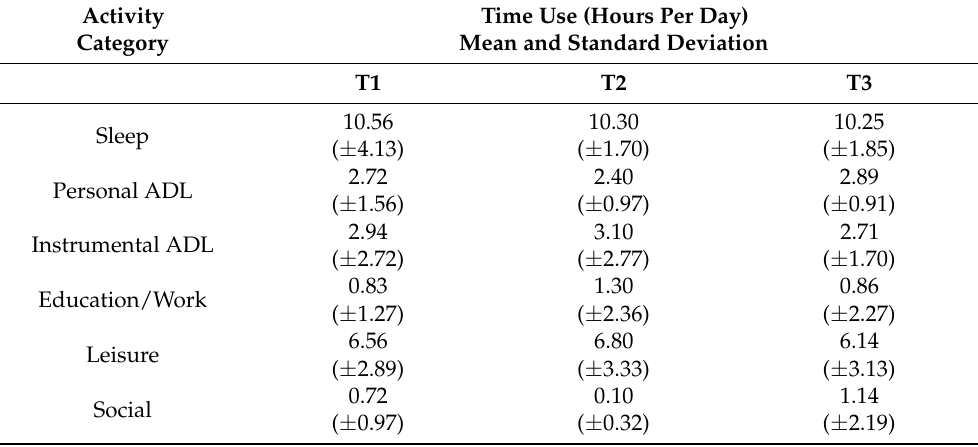
Table 2. Consumer Time Use in Average Hours Per Day.